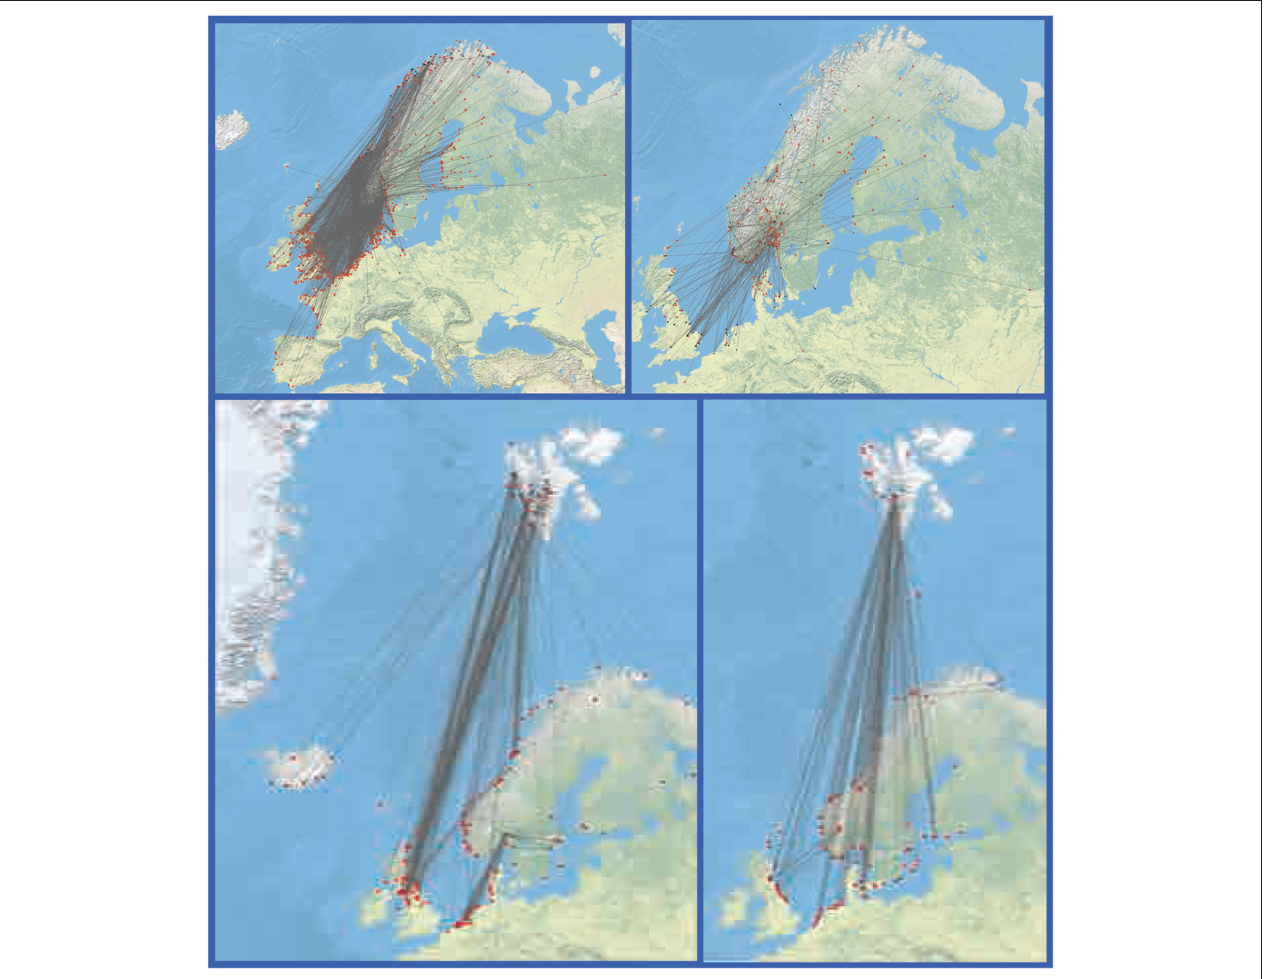
FIGURE 3 | Examples of migration routes for ringed waterfowl. Upper panel show very abundant species with a widespread migration ”all over” (left: common gull— Larus canus ; left: mallard Anas platyrhynchos ). Lower panel are species with a coastal preference that typically link northern Europe, Norway and the Svalbard archipelago (left: purple sandpiper— Calidris maritima ; right: barnacle geese— Branta leucopsis